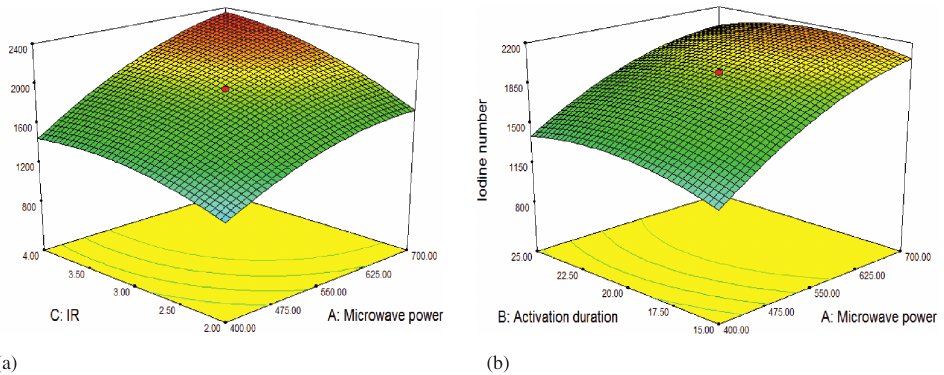
Figure 3: Three-dimensional response surface plot of iodine number: effect of microwave power and IR (a), effect of microwave power and activation duration (b). Table 4: Comparison of iodine numbers of activated carbons prepared from various waste materials by microwave heating.